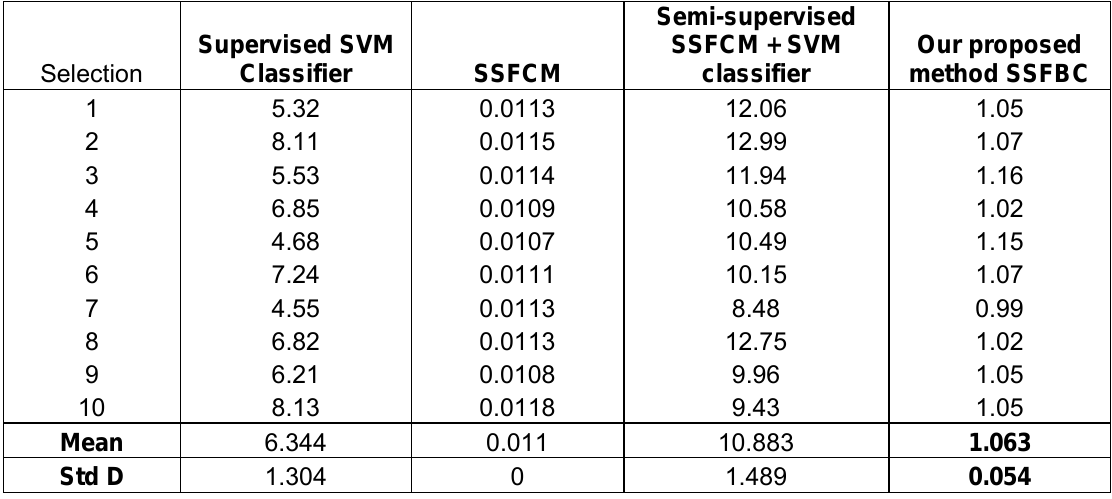
Table 3. Computational time spent for labelling Iris